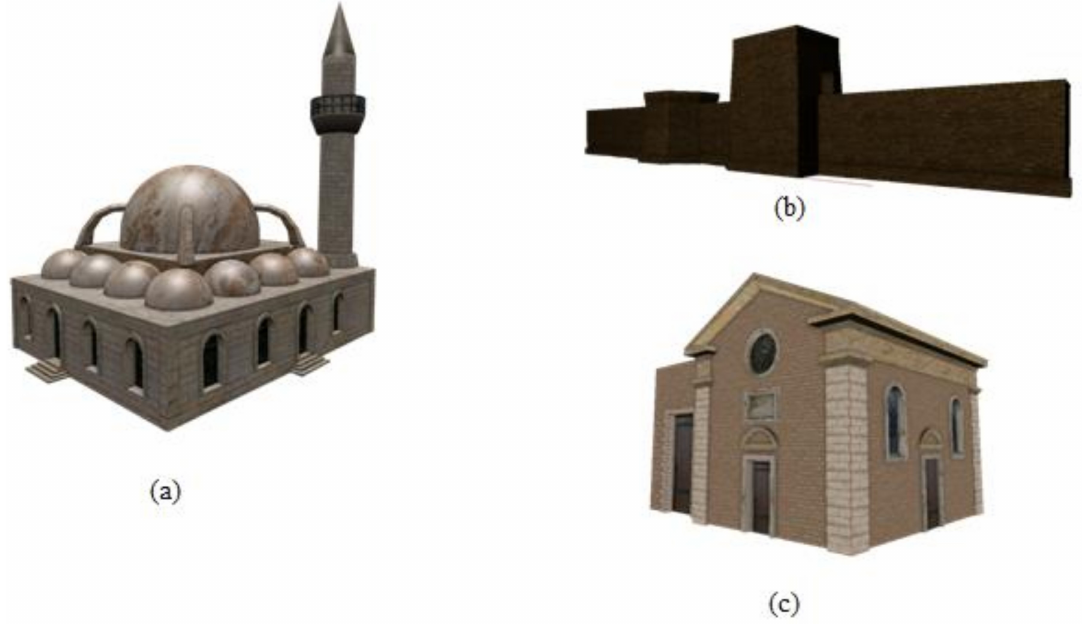
Figure 7. Final textured models, ( a ) Glass Mosque; ( b ) Byzantine wall; ( c ) Saint Rocco